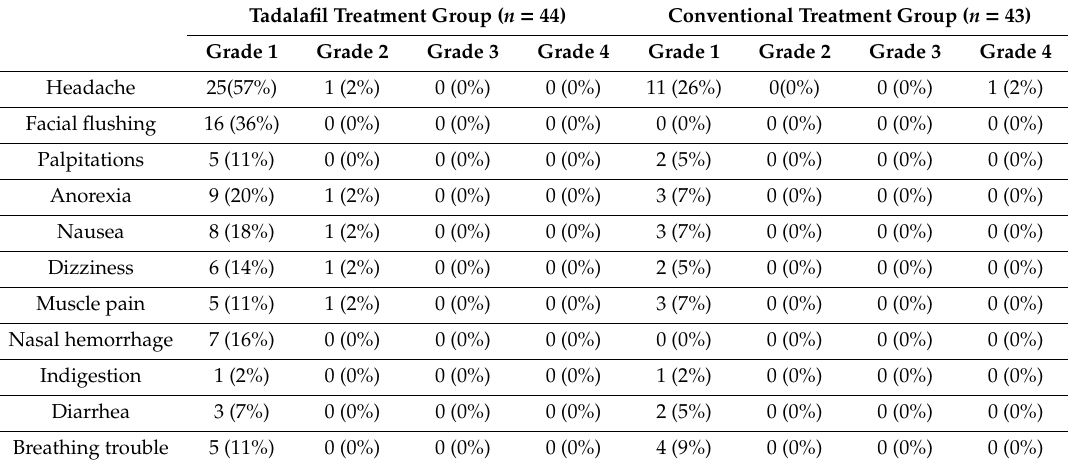
Table 6. Maternal adverse events. NICU: Neonatal intensive care unit.